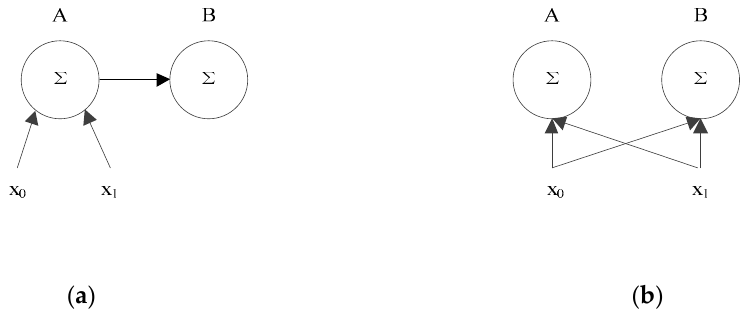
Figure 5. An example of replication computation. ( a ) common method; ( b ) replication computation.